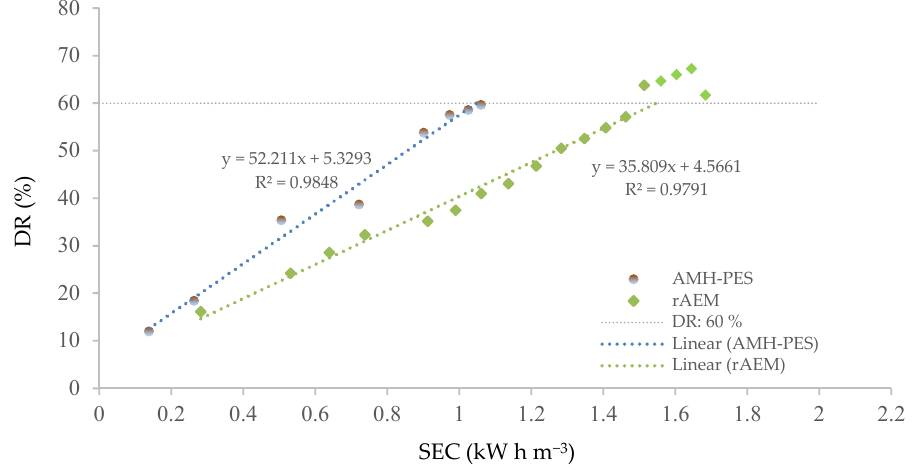
Figure 5. Comparison of demineralization rate (DR, %) of AMH-PES and rAEM based on specific energy consumption (SEC, kW h m − 3 ) by electrodialysis treatment.